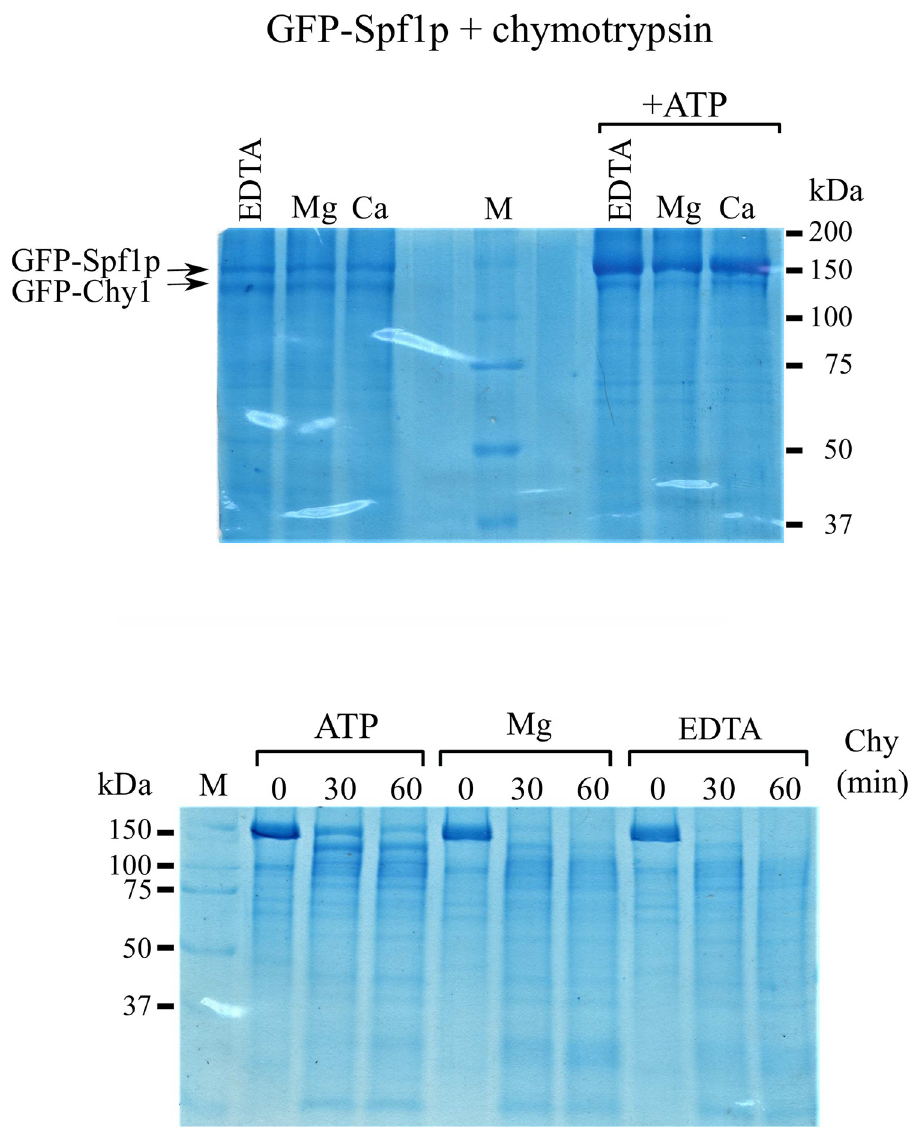
Fig 5. Effect of ATP on chymotryptic digestion of GFP-Spf1p. 3 μ g of GFP-Spf1p was exposed to chymotrypsin (ratio w/w, 30:1) and the reaction was stopped by the addition of TCA. The composition of the proteolytic medium was EDTA , 2 mM EDTA, Mg , MgCl 2 enough to give 2 mM free Mg 2+ , and Ca , CaCl 2 enough to give 100 μ M free Ca 2+ , each condition with or without 3 mM ATP. Top panel , the protein was digested for 30 min. Bottom panel , the proteolysis media were the same as described above and the numbers proteolysis time is indicated on top of each lane.